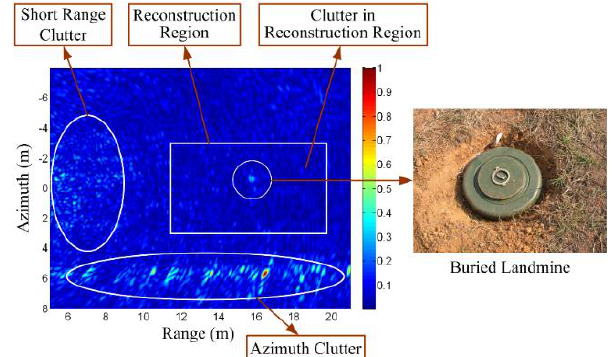
Figure 13. Real data example for the clutter problem in forward-looking GPR (backprojection result using full-sampled data). Taken from [80]. Sensors 2019 , 19 , x 14 of 19